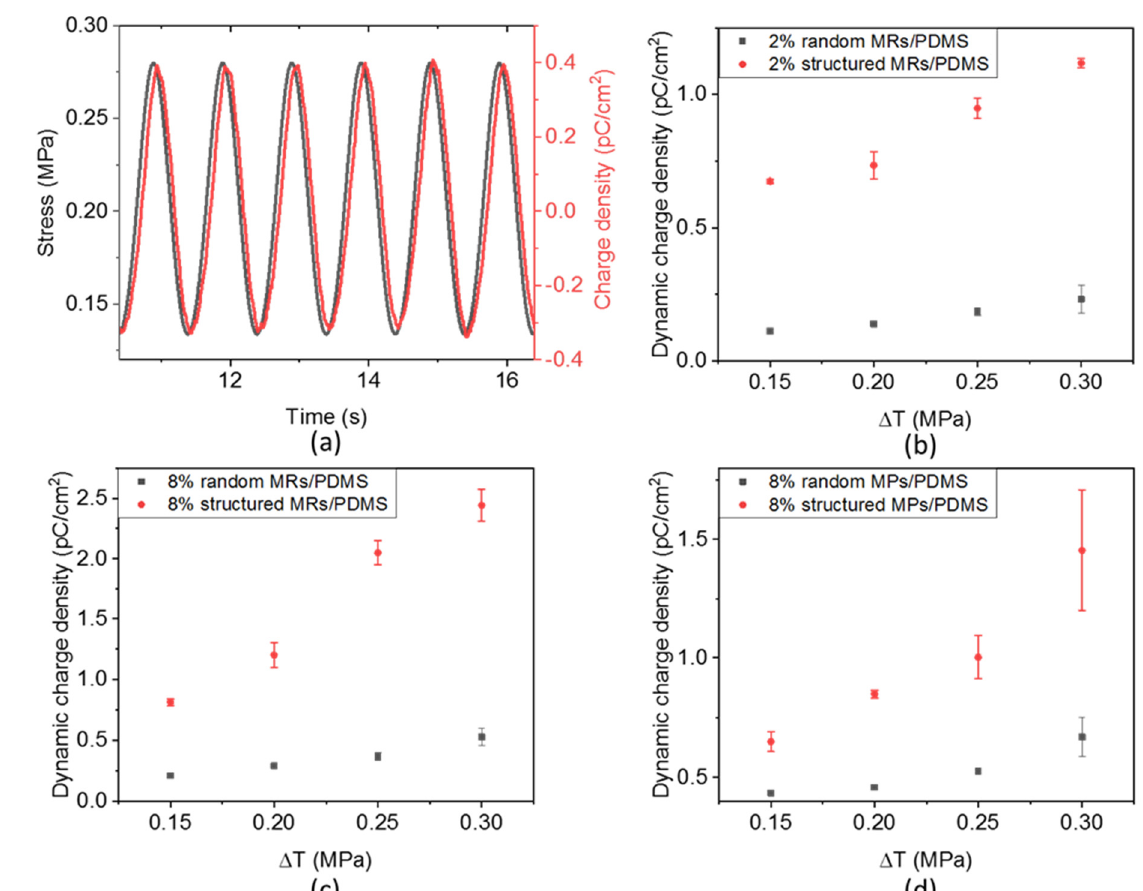
Figure 12. ( a ) Time evolution of the stress and generated charge density in the structured 8% vol. ZnO MR composites under a 0.15 MPa dynamic stress. Increasing dynamic change density ( ∆ D ) versus dynamic stress ( ∆ T ) in ( b ) 2% vol. ZnO MR/PDMS composites, ( c ) 8% vol. ZnO MR/PDMS composites and ( d ) 8% vol. ZnO MP/PDMS composites.